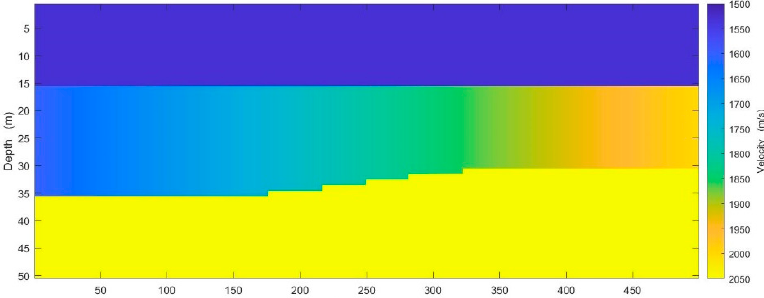
Figure 2. Synthetic Earth model. In the layer below the sea floor, the velocity increases from 1600 to 2000 m/s from left to right, and the layer thickness decreases from 20 to 15 m. We simulated 50 traces, equally spaced from left to right along the model.